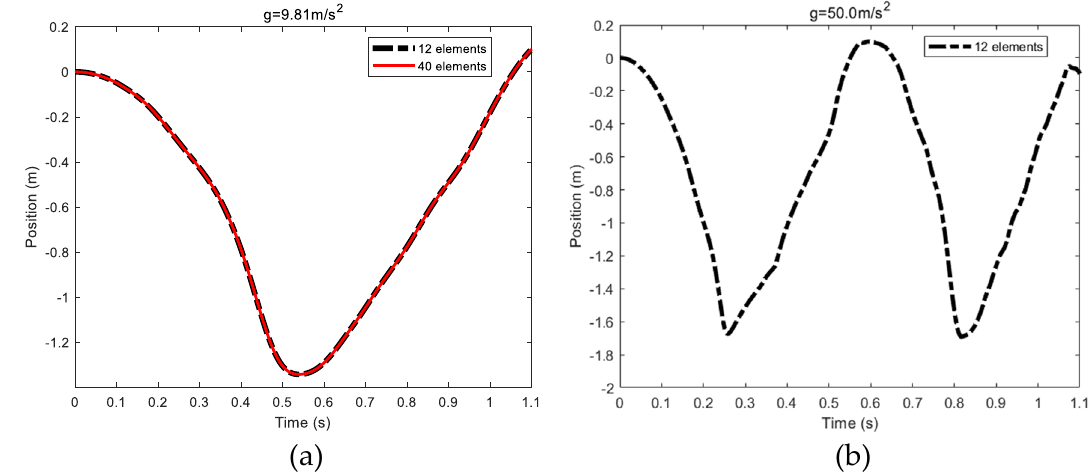
Figure 8. Vertical position of the free end of the pendulum. ( a ) The beam using 12 elements and 40 elements, g = 9.81 m/s 2 . ( b ) The beam using 12 elements, g = 50.0 m/s 2 .